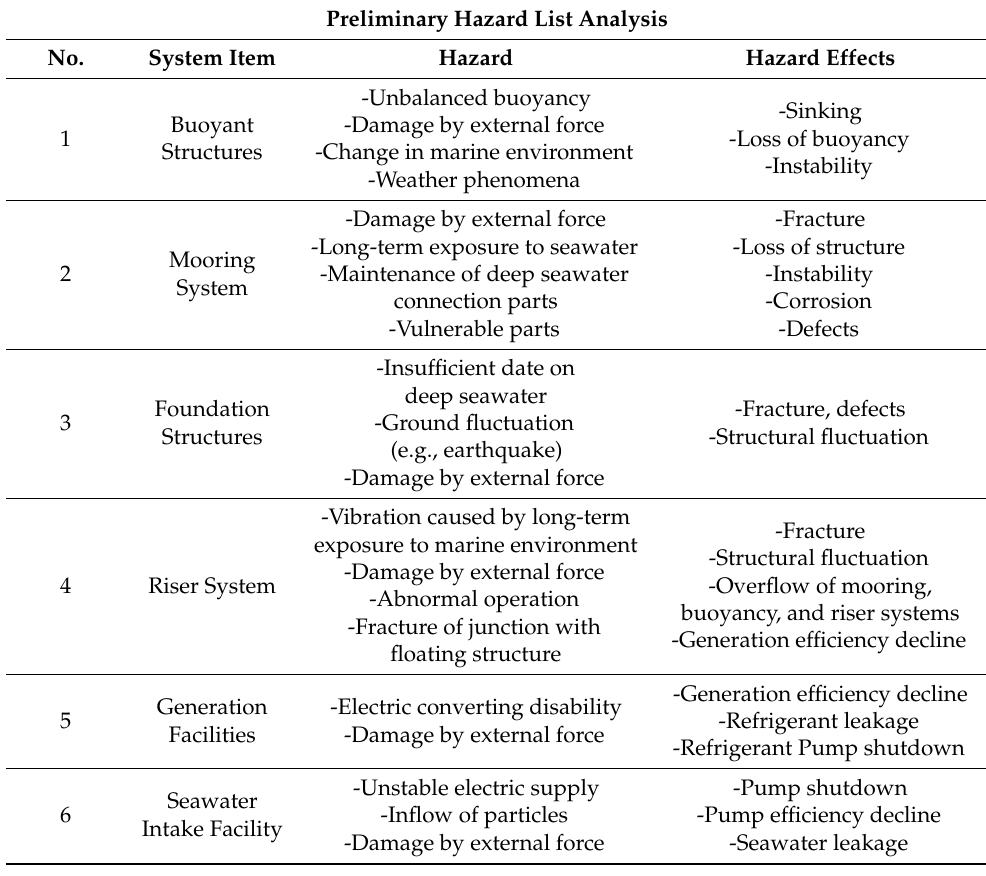
Table 1. Results of the MW-scale OTEC Preliminary Hazard List